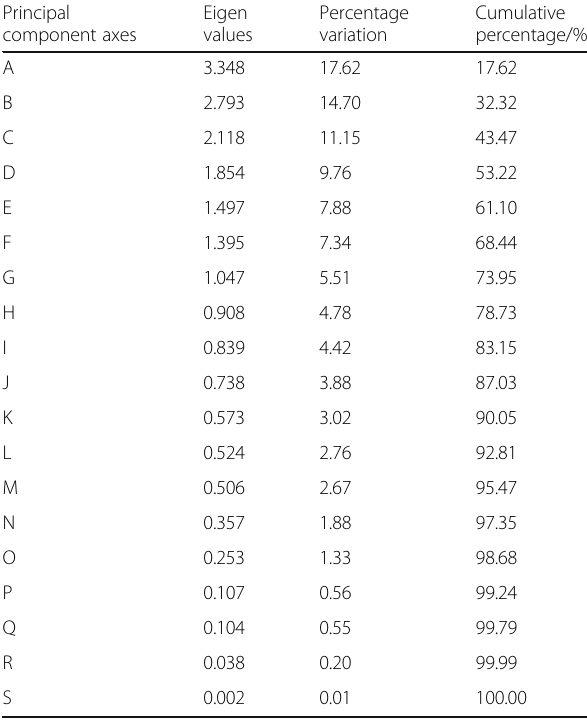
Table 1 Eigen values and percentage of variation for 19 principal component axes in 100 cotton genotypes Principal component axes